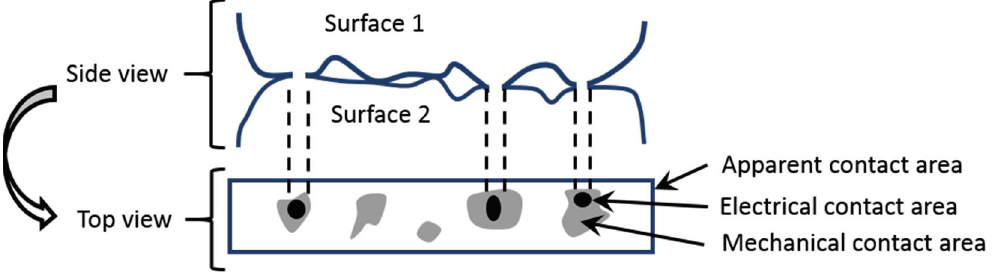
Figure 5. Illustration of the apparent, mechanical, and electrical contact